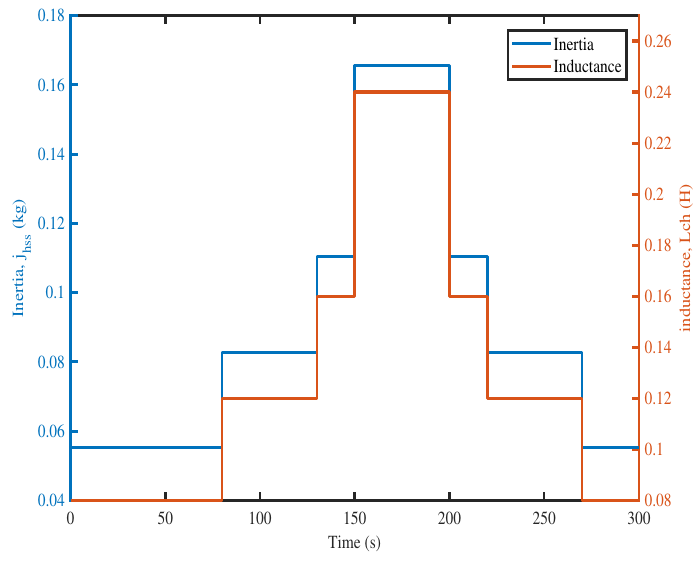
Figure 12. Varying load, varying